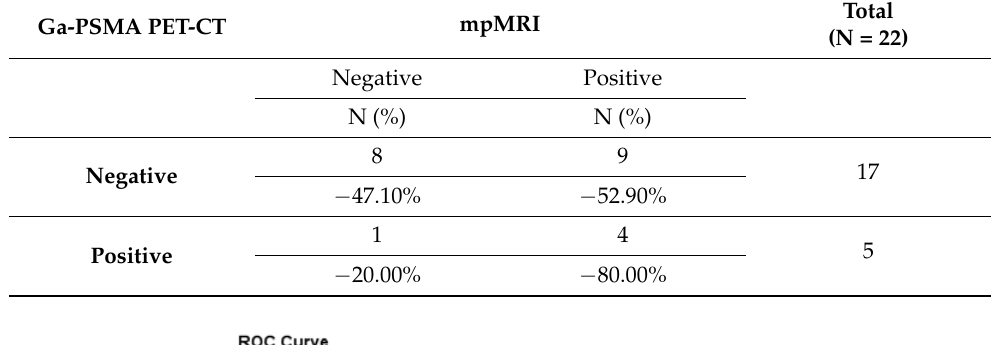
Table 5. Comparison between mpMRI and Ga-PSMA PET-CT.